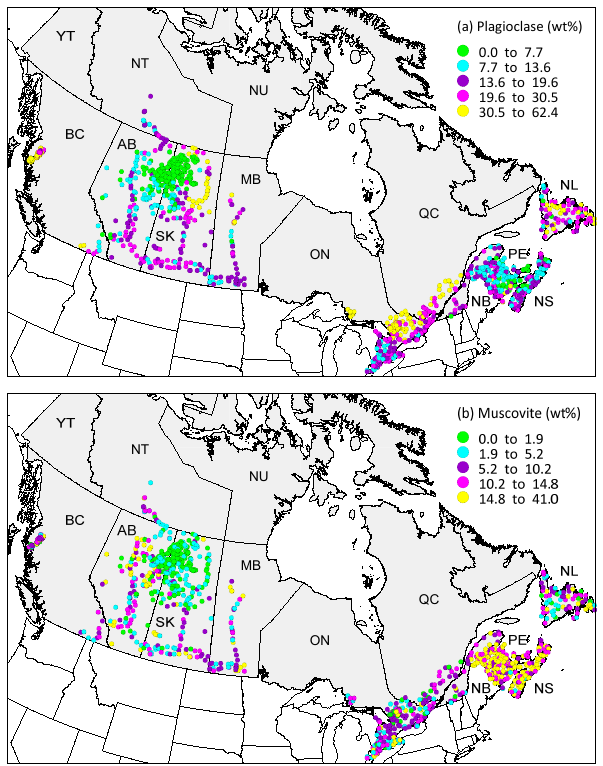
Figure 5. Predicted A2M (Analysis to Mineralogy) quantitative mineralogy (wt%) for ( a ) plagioclase and ( b ) muscovite in soils (depth-weighted to a maximum of 50 cm) for study sites across Canada from the North America Soil Geochemical Landscapes Project and Trent University Soil Archive ( n = 1170). Legends were set to obtain an equal distribution of sites among fi ve categories.